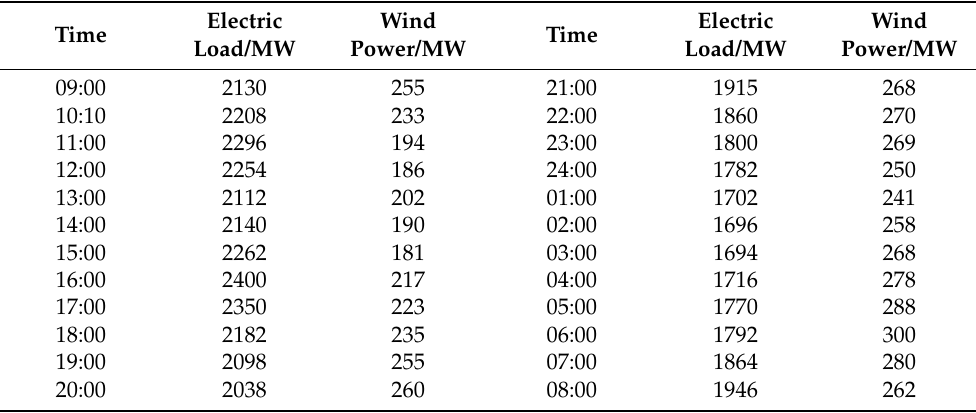
Table 5. Wind power forecast and electric load forecast.